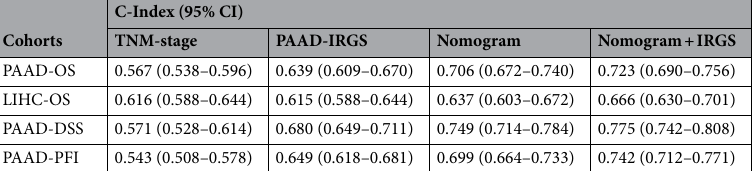
Table 3. The C-Index values of TNM-stage, PAAD-IRGS, nomogram and nomogram + IRGS in different cohorts. C-Index concordance index, IRGS immune-related genes signature, PAAD pancreatic adenocarcinoma, LIHC liver hepatocellular carcinoma, OS overall survival, DSS disease specific survival, PFI progress free